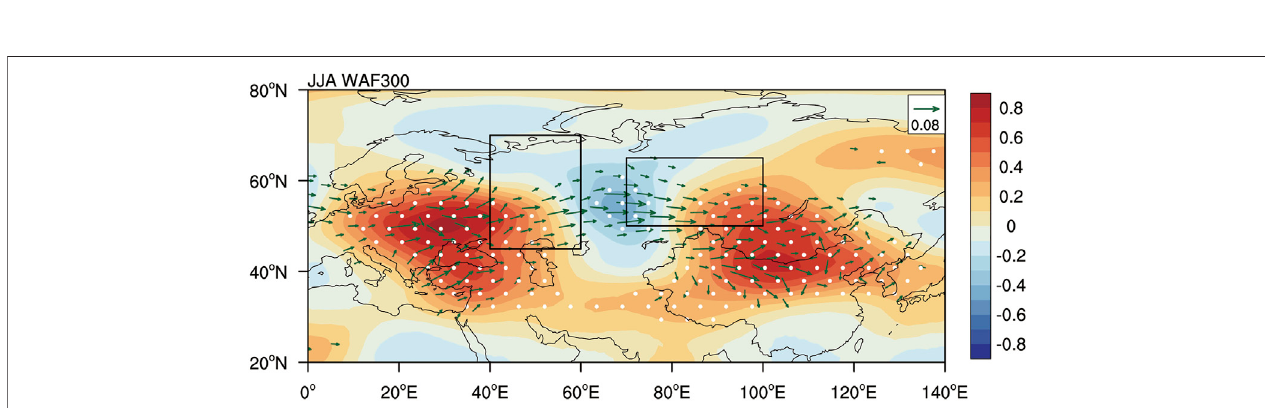
FIGURE 7 | Anomalies of 300-hPa stream function (shading; m2 s − 1) and the associated wave activity fl ux (vectors; m2 s − 2) regressed onto the SSDI during summer(JJA).Theblackrectangles arethesame as Figure 1A , andthe stippling denotestheregressioncoef fi cients statistically signi fi cantat the95%con fi dence level.